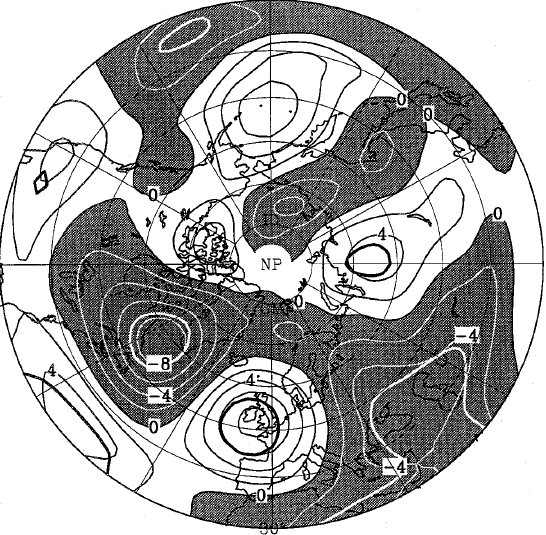
Fig. 7. Decadal change in the period 1979–97 of geopotential disturbance. Shaded area : negative; D d G */dt = 2 gpm/y. Thick encircled areas are significant